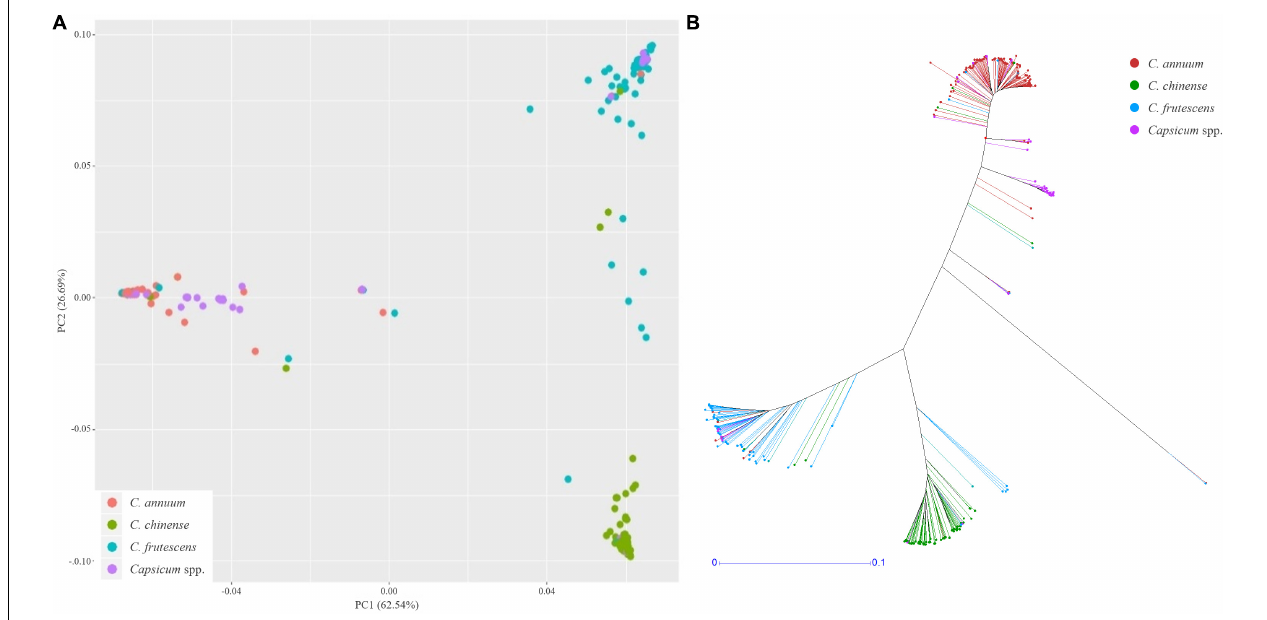
FIGURE 5 | Population structure analysis of the CSHL population, with a principal component analysis (A) and a phylogenetic tree (B) determined from 156,589 SNPs. Red, green, sky blue and purple colors indicate C. annuum , C. chinense , C. frutescens and Capsicum spp. accessions, respectively.